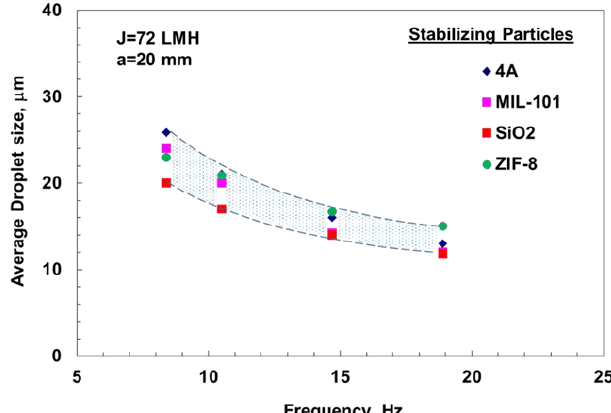
Figure 6. Change in droplet size with frequency for different particle-stabilized emulsions.